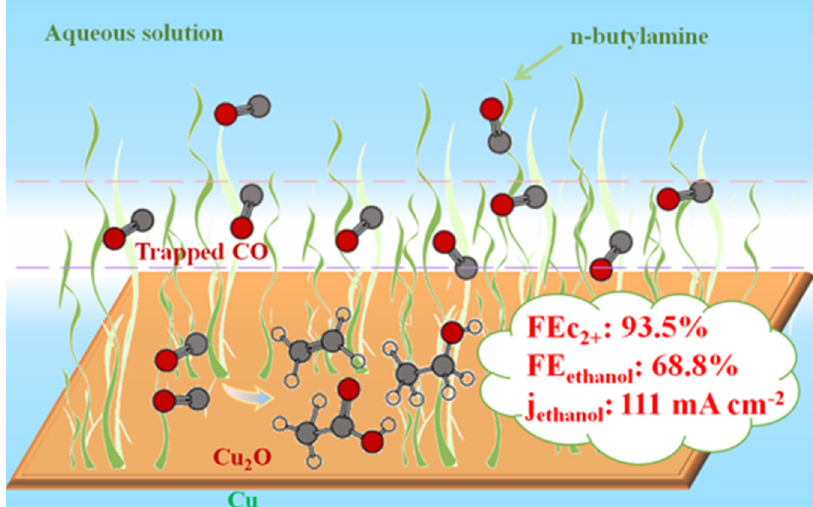
Fig. 1 | Schematic illustration of the hydrophobic Cu/Cu 2 O catalyst designed for CORR. The n-butylamine on the Cu/Cu 2 O surface is used to trap the CO